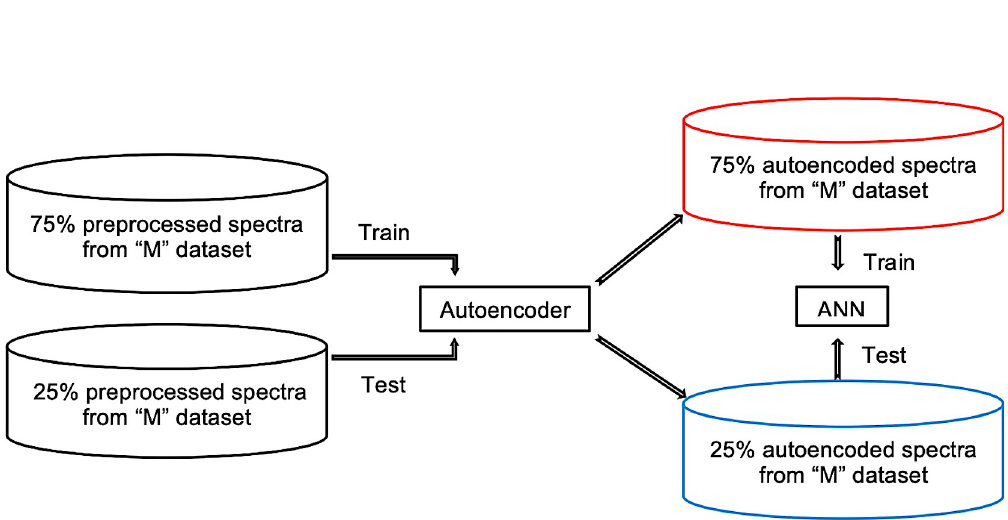
Fig 5. Training and testing of ANN model on autoencoded spectra. M is either Minepa-ARA, Muleba-GA, Burkina-GA, or Muleba-Burkina-GA dataset.